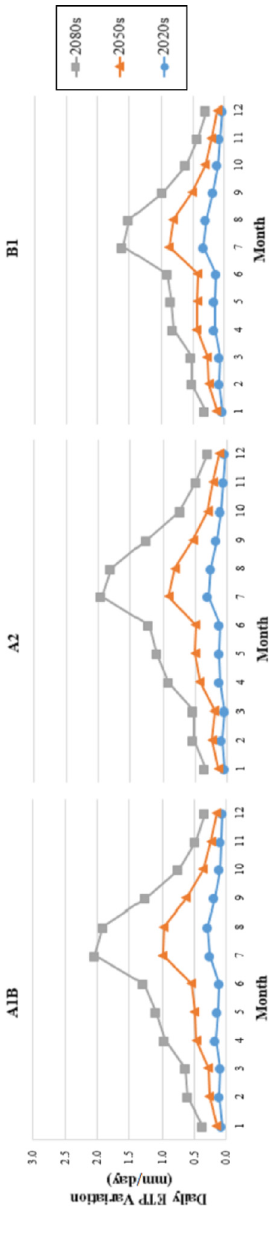
Figure 6. Daily ETP changes compared with the observed period in Ilam